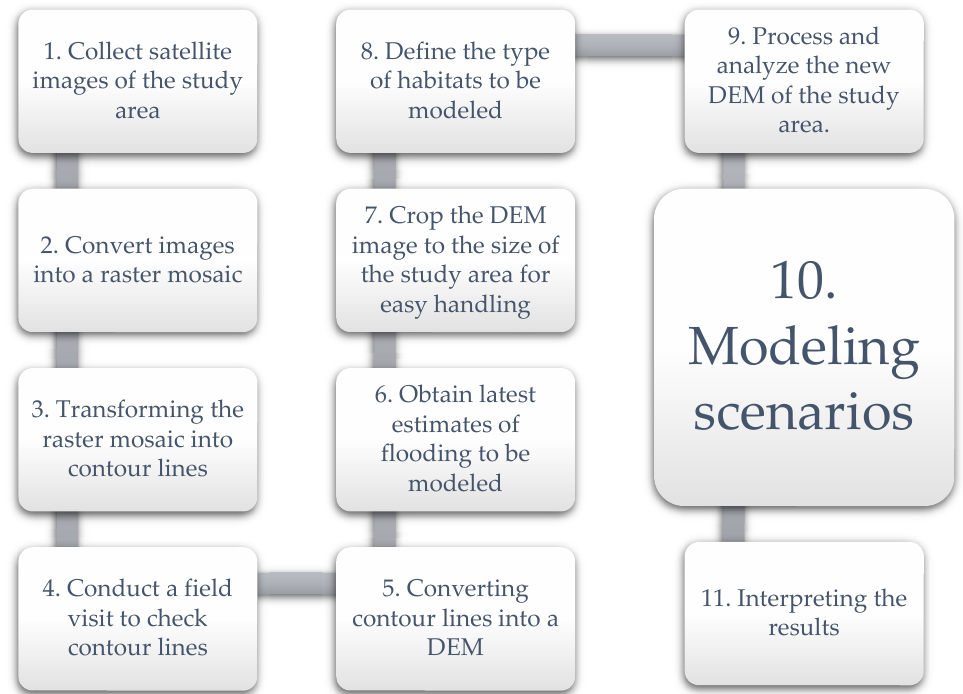
Table 1. Geographical boundaries of the study area.